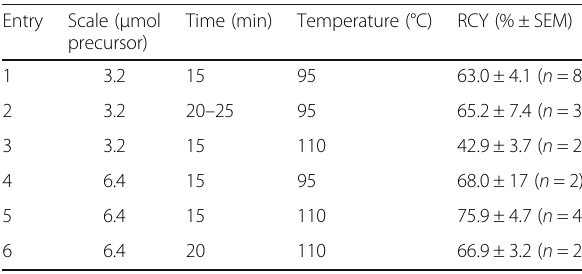
Table 3 Iterative n.i. RCY optimisation of compound [ 18 F]5. Values derived from TLC chromatogram analysis Entry Scale ( μ mol precursor)